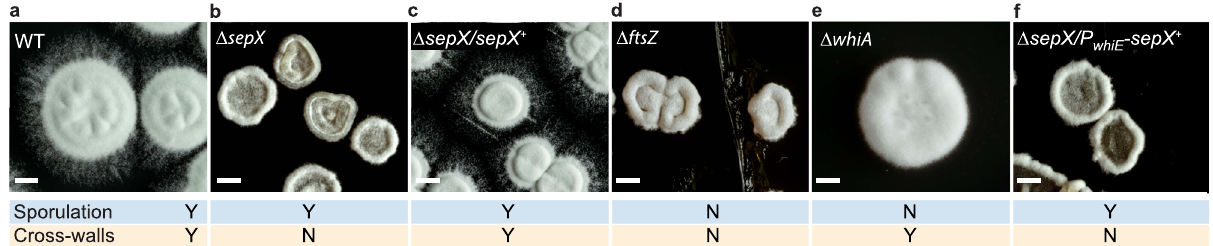
Fig. 3 Cross-walls are crucial for cellular development of S. venezuelae . Representative images of the colony morphology of a the wild type (WT), b the Δ sepX mutant (SV55), c the complemented mutant (MB181), d the Δ ftsZ mutant (DU669), e the Δ whiA mutant (SV7), or f the conditional sepX mutant expressing sepX from the sporulation-speci fi c whiE promoter (MB1120). All strains were grown on solid MYM and photographed after 3 days. “ Y ” (Yes) and “ N ” (No) indicate whether strains can form cross-walls and/or sporulation septa. Scale bars: 1